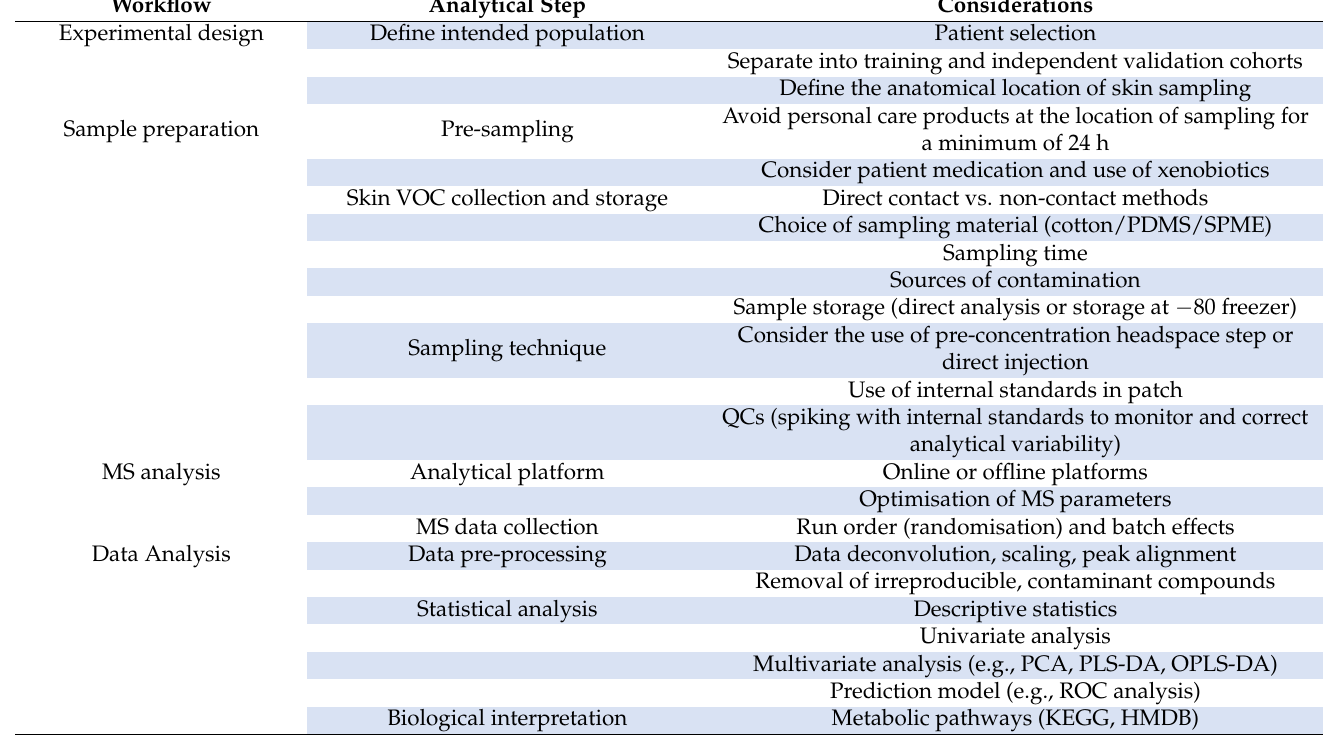
Table 2. Considerations for the analysis of skin volatile organic